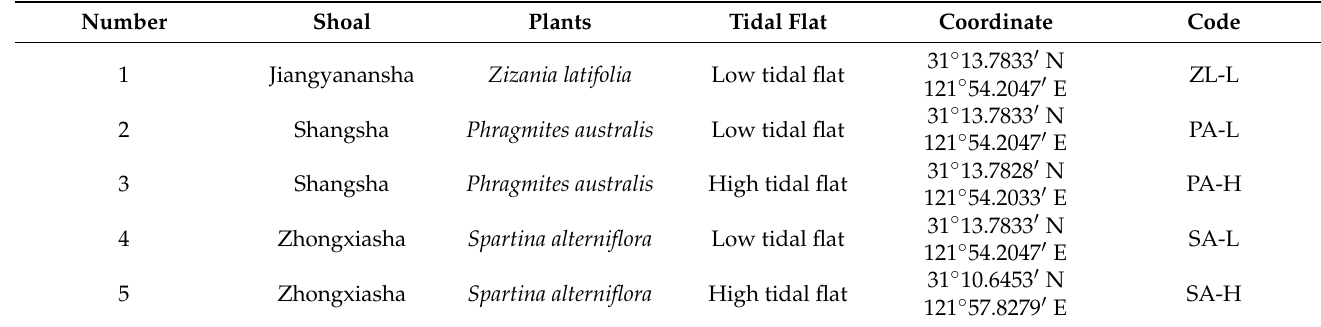
Table 1. Basic details of the different